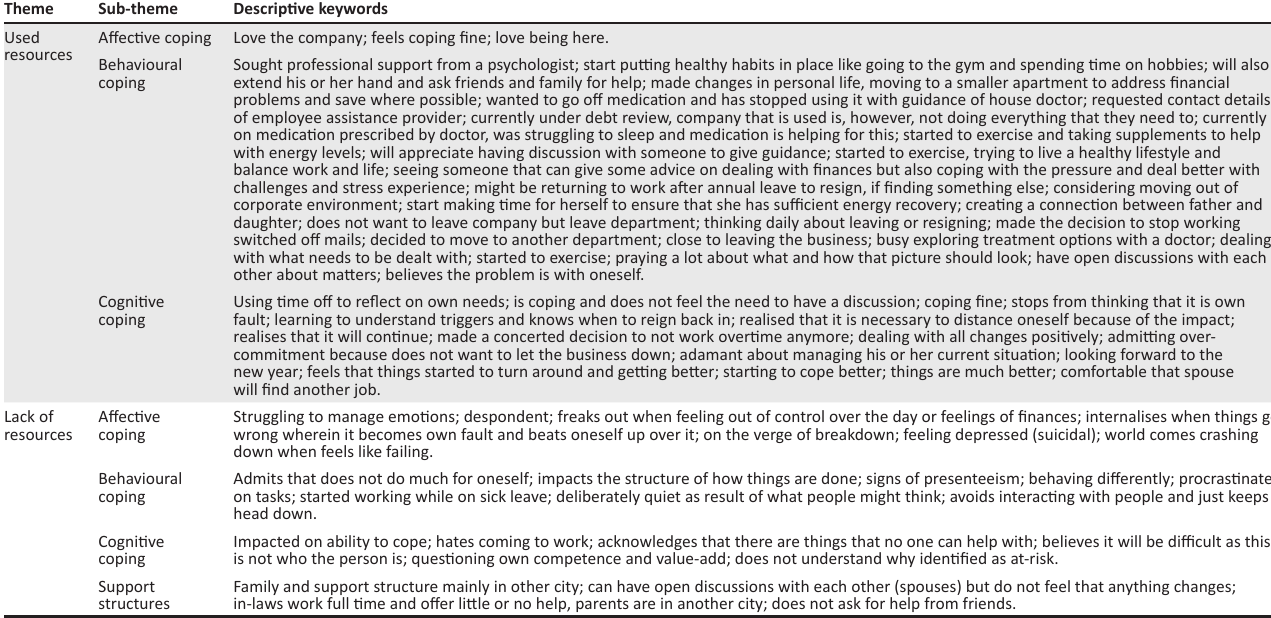
TABLE 2: Personal